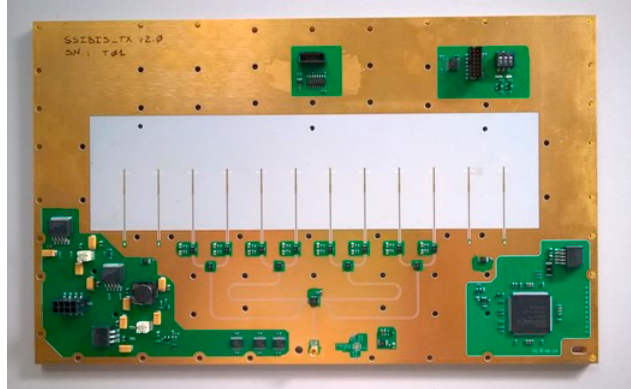
Figure 6. Transmitting antenna module.